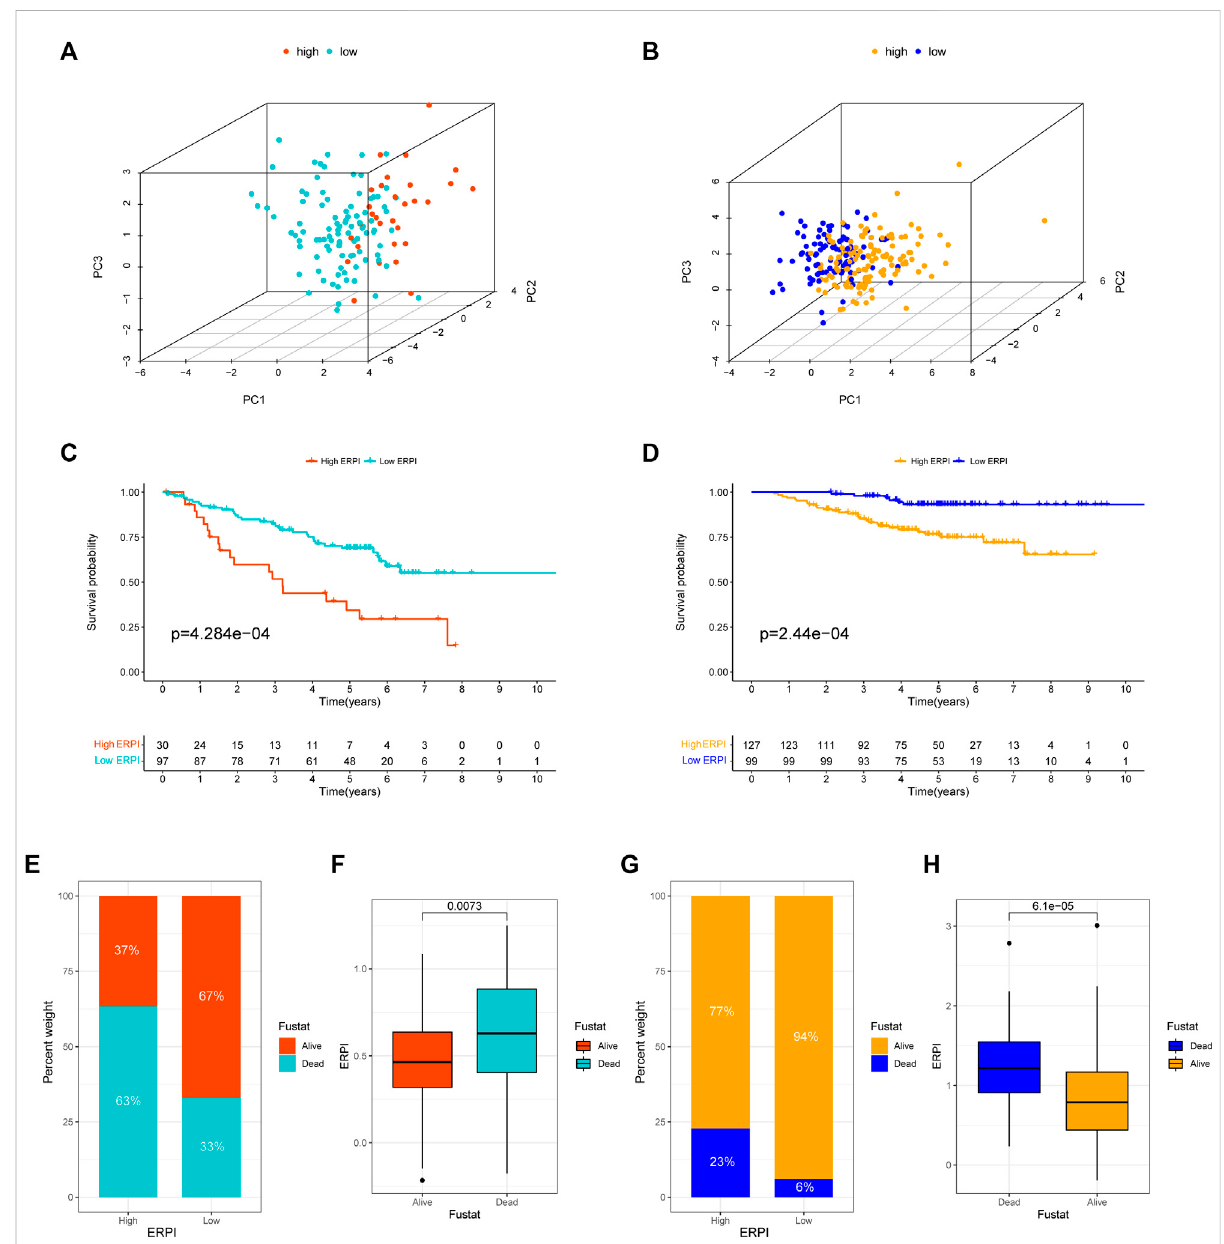
FIGURE 3 ValidationofERPIinGSE50081and GSE31210. (A) Distribution ofhigh- andlow-ERPIgroupsinPCAbasedontheexpression of14 EMT-related lncRNAs in the prognostic model in GSE50081. (B) Distribution of high- and low-ERPI groups in PCA based on the expression of 14 EMT-related lncRNAsintheprognosticmodelinGSE31210. (C) Survivalcurvesofthehigh-andlow-ERPIgroupsinGSE50081. (D) Survivalcurvesofthehigh-and low-ERPIgroupsinGSE31210. (E) Proportionofdeadandlivingpatientsinthehigh-andlow-ERPIgroupsinGSE50081. (F) ERPIofthedeadand living patients in GSE50081. (G) Proportion of dead and surviving patients in the high- and low-ERPI groups in GSE31210. (H) ERPI of the dead and surviving patients in